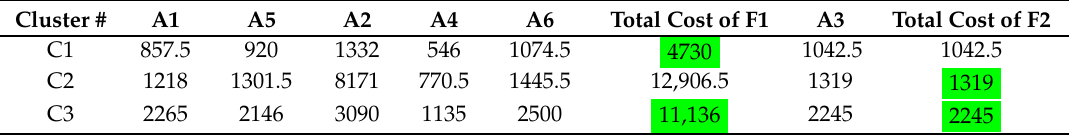
Table 20. Phase 1, final allocation over cluster of sites in both works.